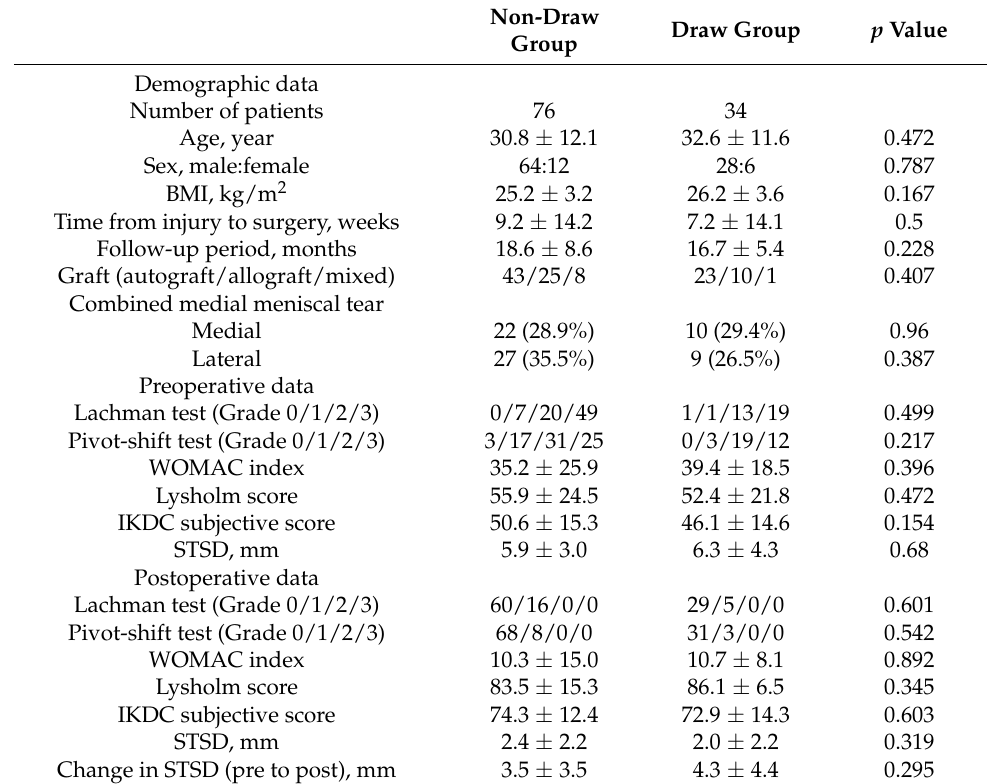
Table 3. Comparison of outcomes between both